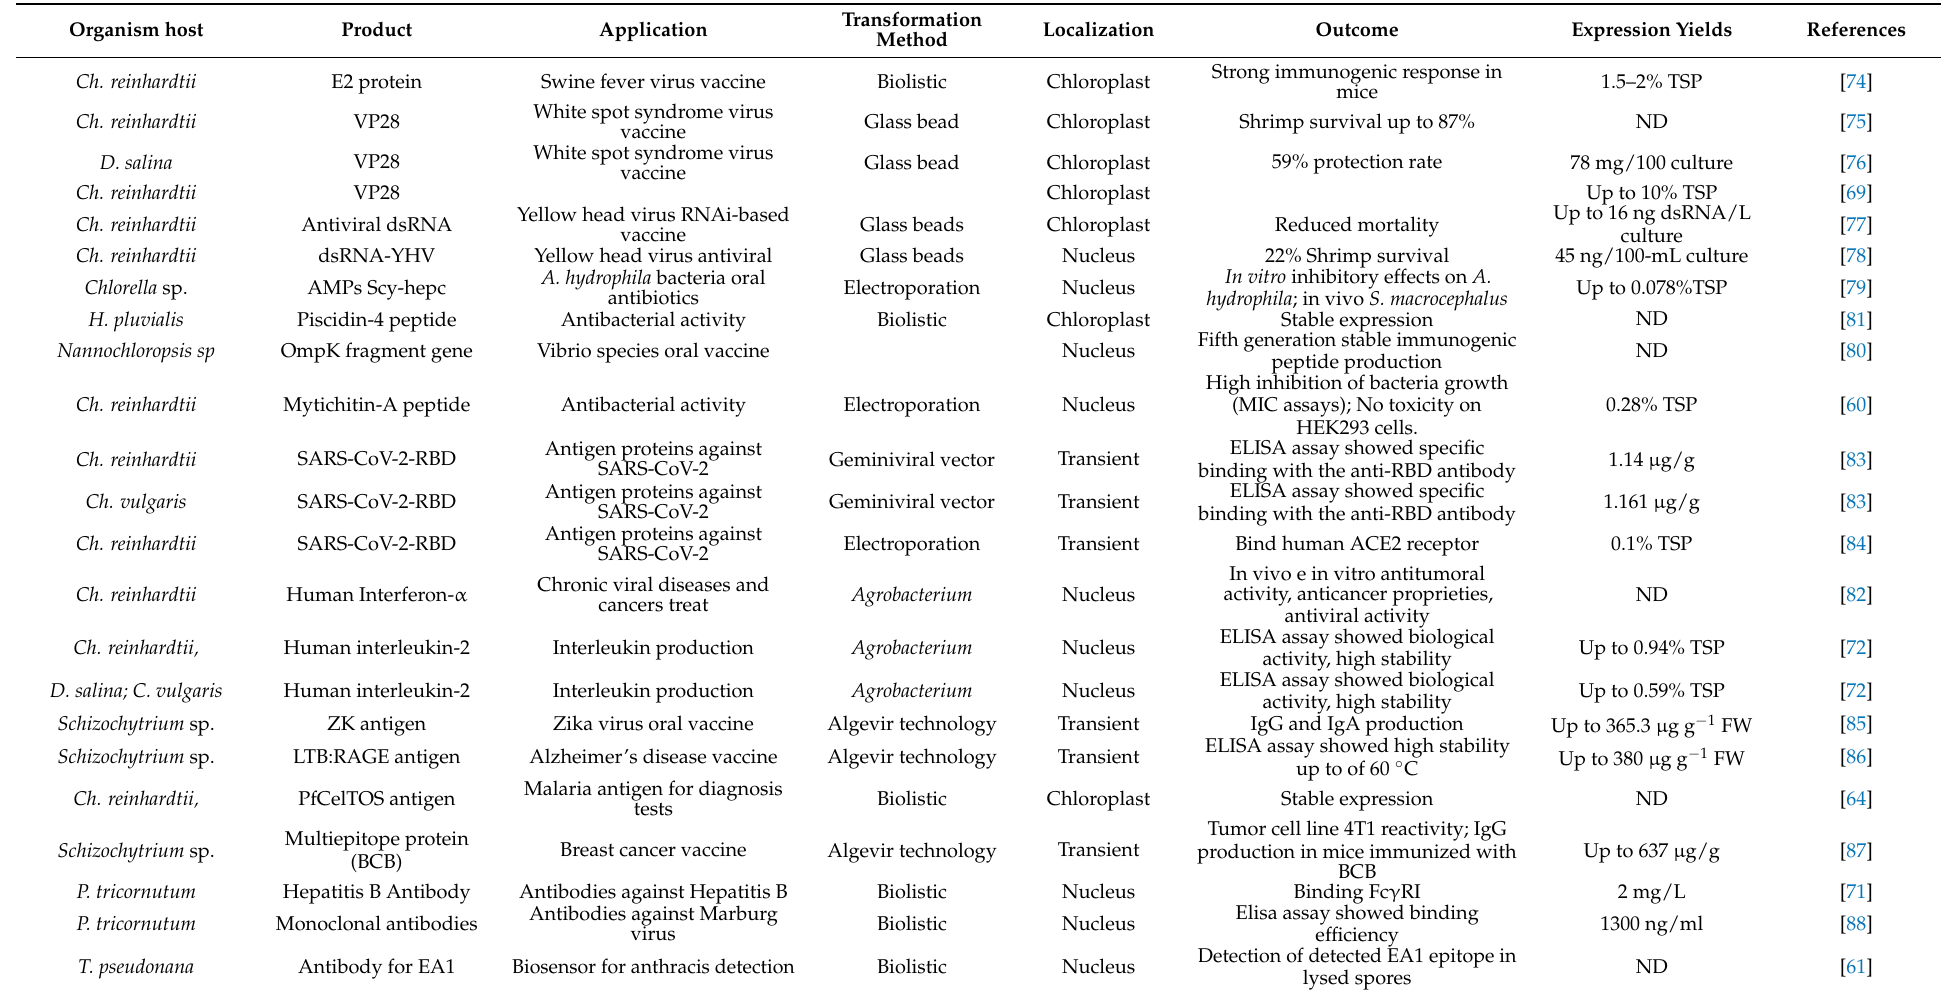
Table 2. List of pharmaceutical products obtained by engineered